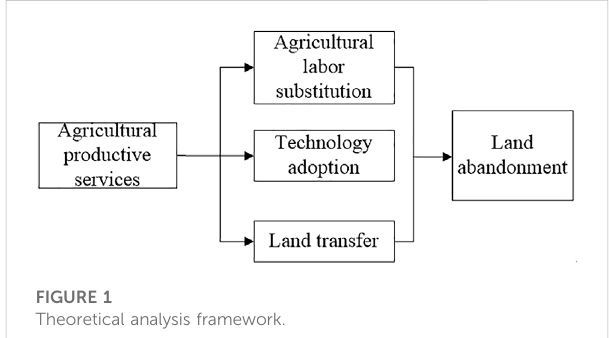
FIGURE 1 Theoretical analysis